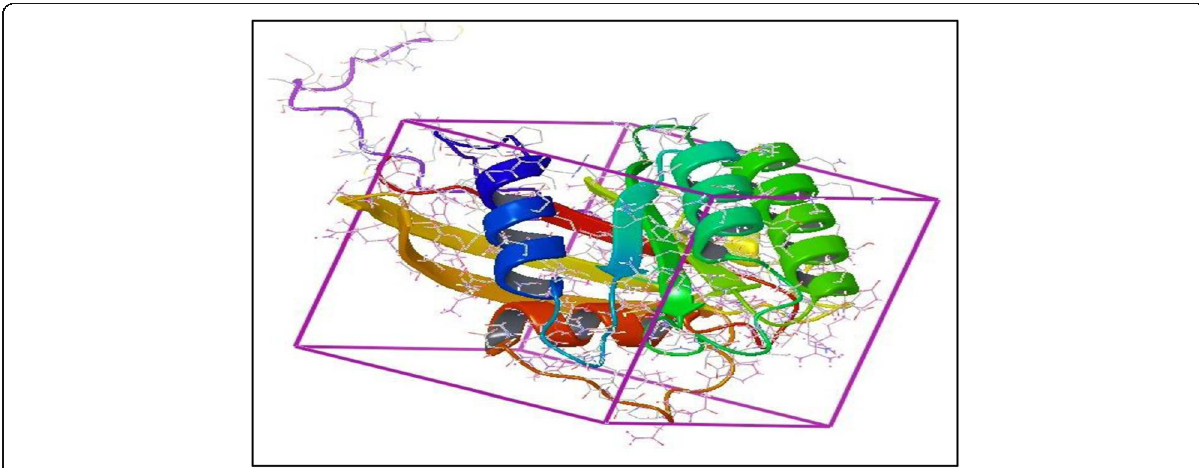
Fig. 10 Grid generation around binding site region: The grid generated with 70Å × 70Å × 70Å dimensions using receptor grid generation of Glide module [46]